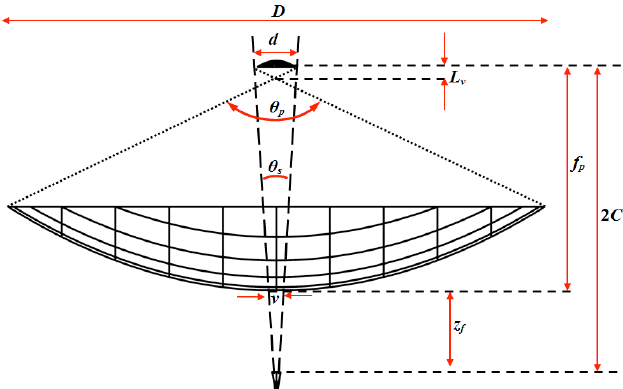
Figure 5: Optical arrangement of an on-axis Gregorian